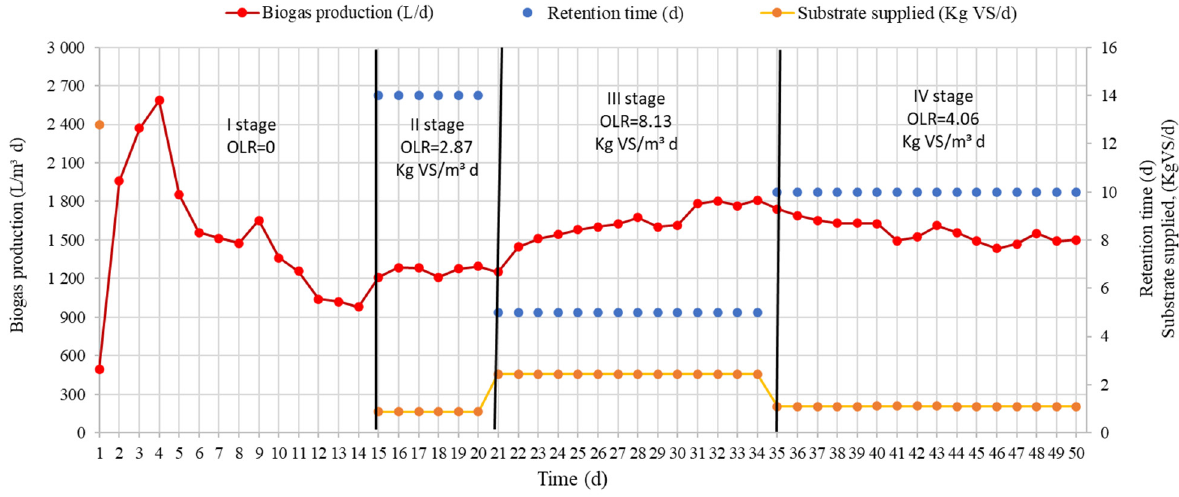
Figure 2. Dependence of biogas production on residence time and OLR.